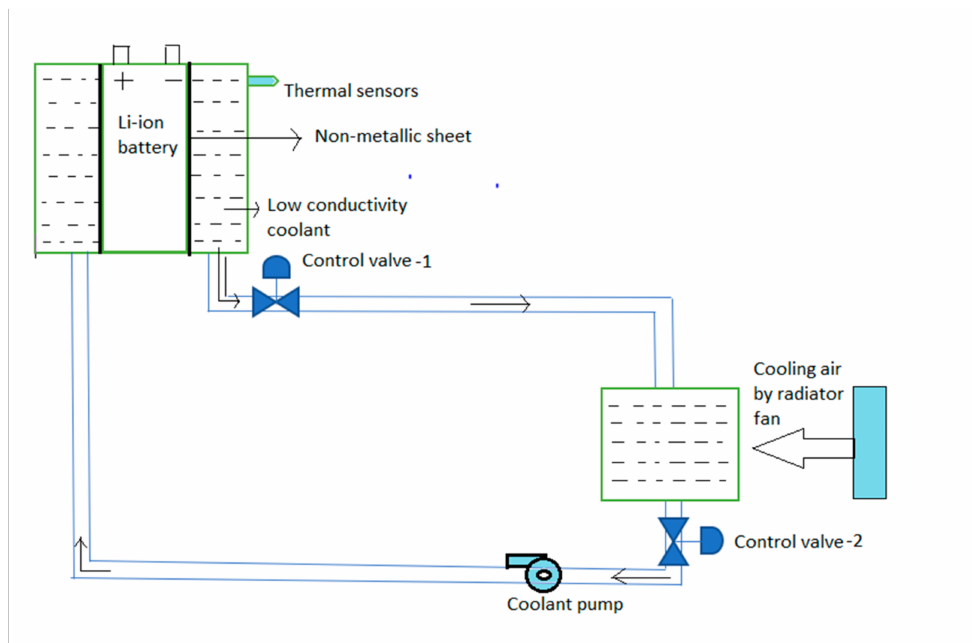
Figure 9. Proposed immersion based liquid cooling method for LiFePO 4